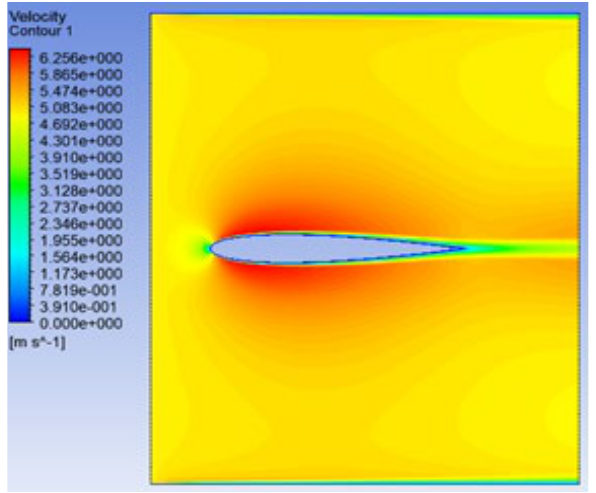
Figure 7. Velocity variation of NACA0012 From the pressure variation on NACA2415 profile, it is of behaviors. The higher pressure values at the leading edge that is the impact point, red color shows a higher value of pressure, where blue color is indicating the least value of pressure. Near the side edges, the pressure is reduced for both the profiles, and this variation in pressure helps in lift force, and those are presented in figures 6 to 9.